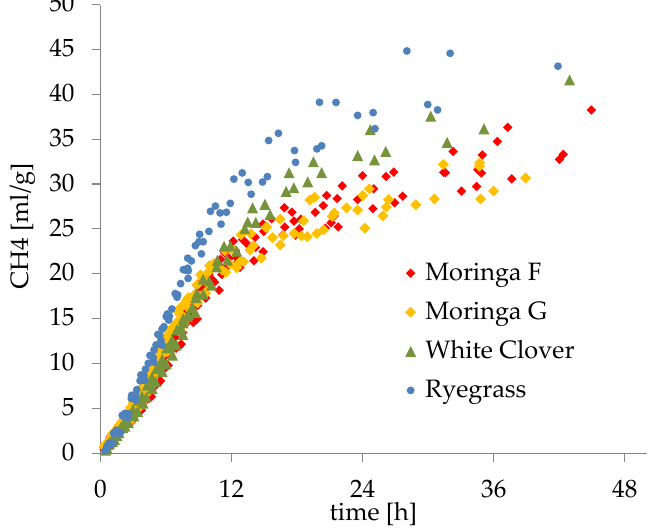
Figure 1. Real-time production of methane (mL/g) for M . oleifera in field (Moringa F) and in green- house (Moringa G), ryegrass and white clover.